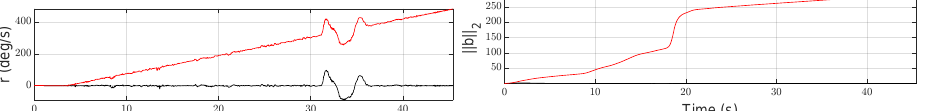
( b ) Norm of the estimated gyro biases from both IMUs.